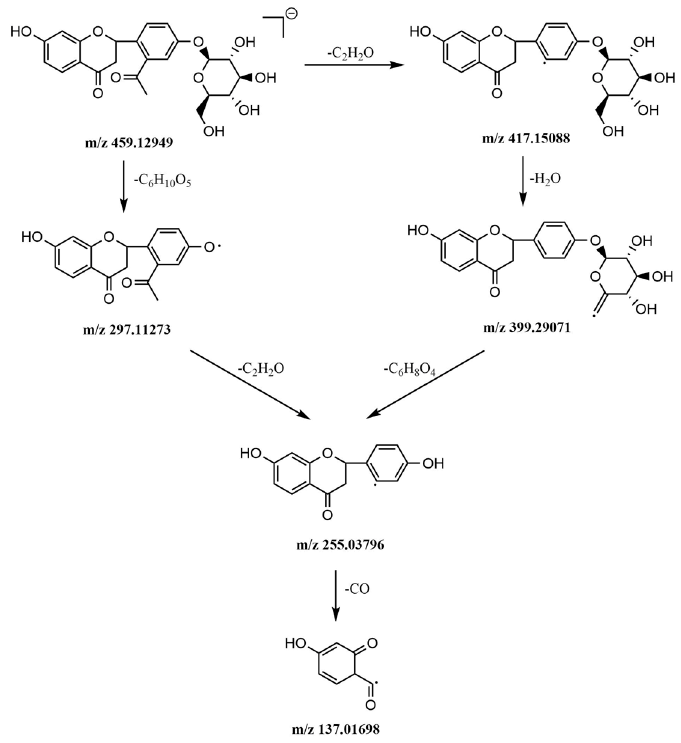
Figure 7. The mass spectrometric fragmentation processes of peak 29 6 ′ -Acetyl liquiritin.